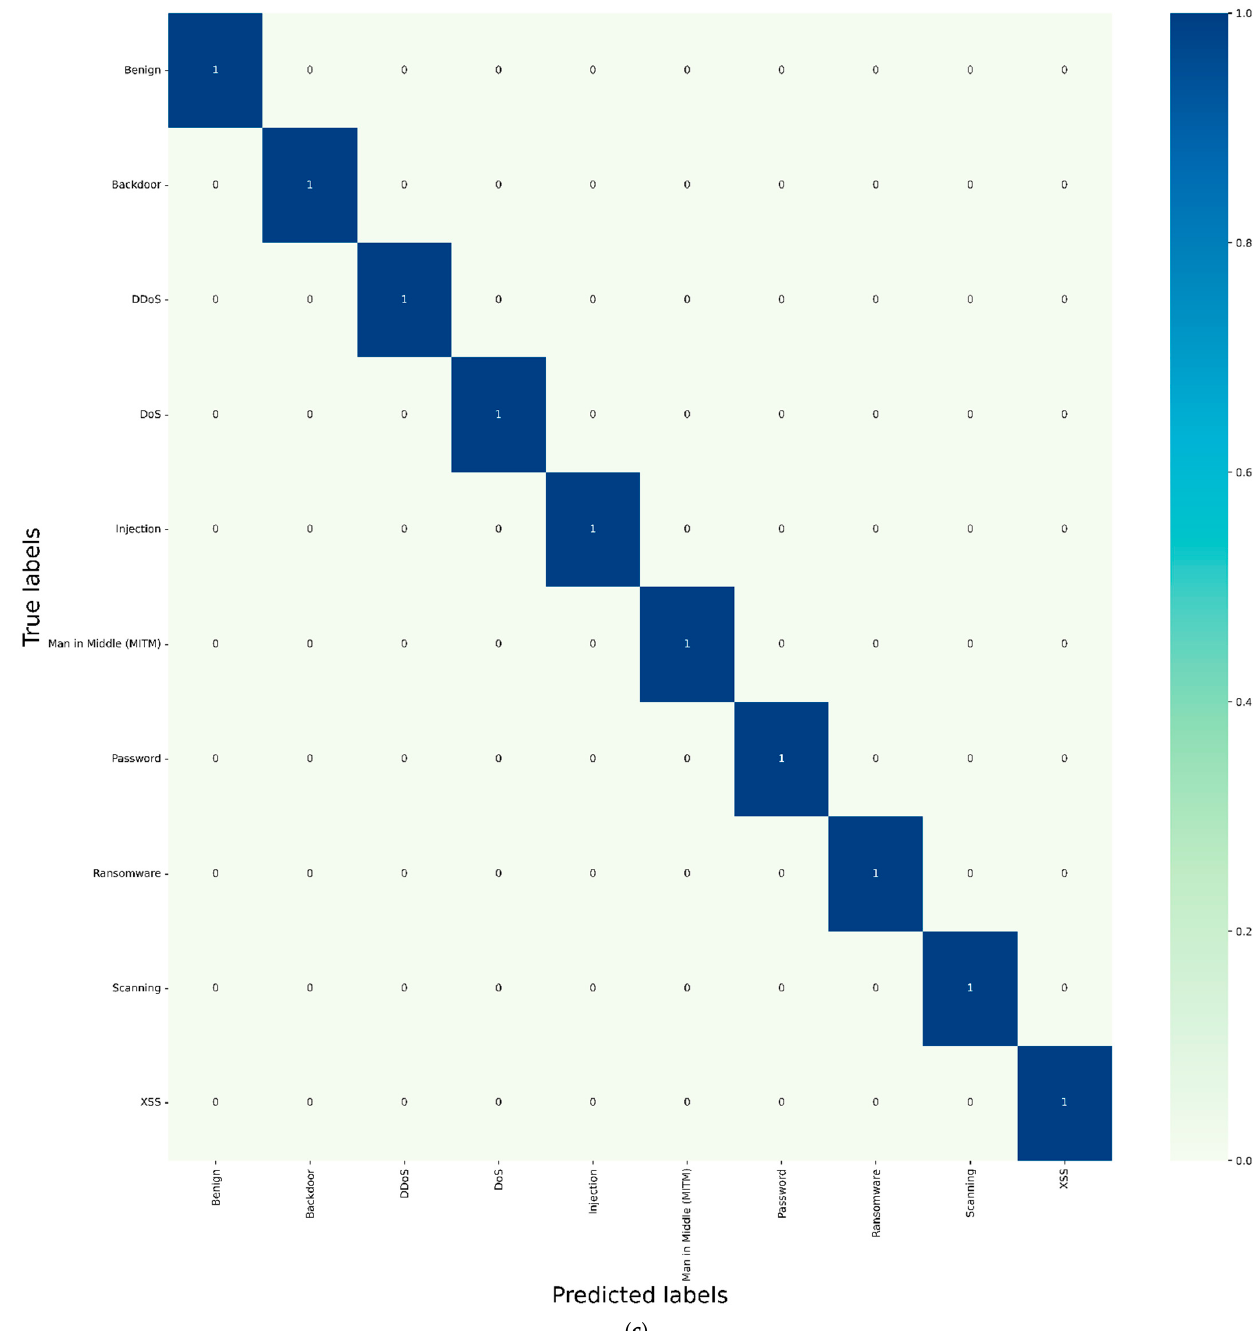
Figure 3. Confusion matrices of ( a ) BoT-IoT, ( b ) IoTID20, and ( c )